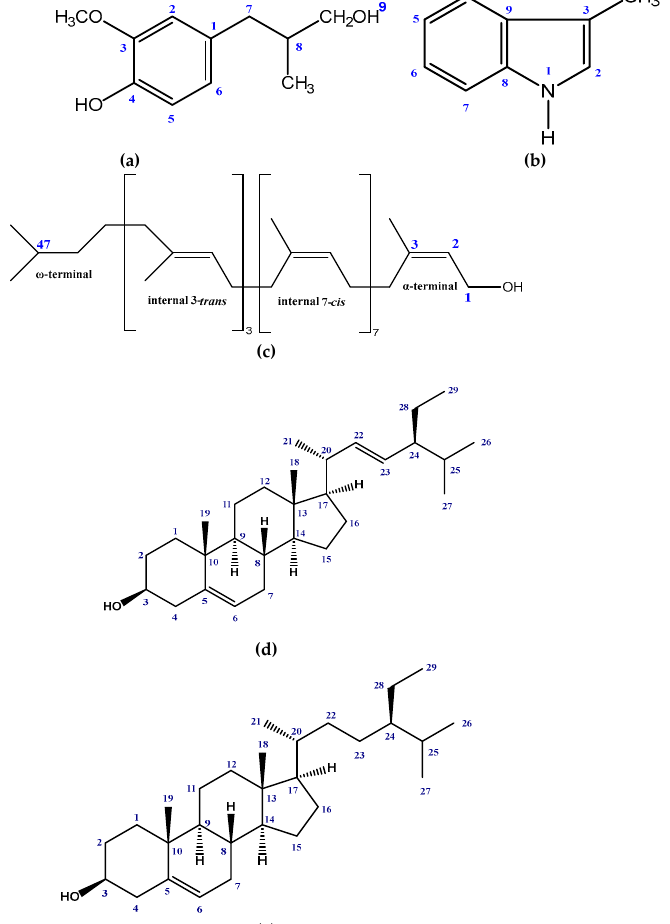
Figure 1. Structures of Isolated phytochemicals from Glycosmis cyanocarpa using NMR techniques: ( a ) 4-(3-hydroxy-2-methylpropyl)-2-methoxyphenol, ( b ) 3-methyl-1 H -Indole, ( c ) Tri-transpoly-cis prenol-12, ( d ) Stigmasterol and ( e ) β -Sitosterol. (4-(3-hydroxy-2-methylpropyl)-2-methoxyphenol) ( 1 ): Yellow mass and soluble in meth- anol and chloroform; 1 H NMR (400 MHz, CDCl 3 ): δ 6.53 (1H br s, H-2), 6.82 (1H d, J = 8.0 Hz, H-5), 6.60 (1H d, J = 8.0 Hz, H-6), 2.57 (2H br t, J = 6.8 Hz, H-7), 2.55 (1H m, H-8), 3.93 (2H m, H-9), 3.85 (3H s, OCH 3 -3), 0.86 (3H m, CH 3 -8). 13 C NMR (100 MHz, CDCl 3 ): δ 132.32 (C-1), 111.05 (C-2), 146.40 (C-3), 143.90 (C-4), 114.09 (C-5), 121.32 (C-6), 46.47 (C-7), 39.23 (C-8), 73.30 (C-9), 55.79 (OCH 3 -3), 14.14 (CH 3 -8) (Table S1).